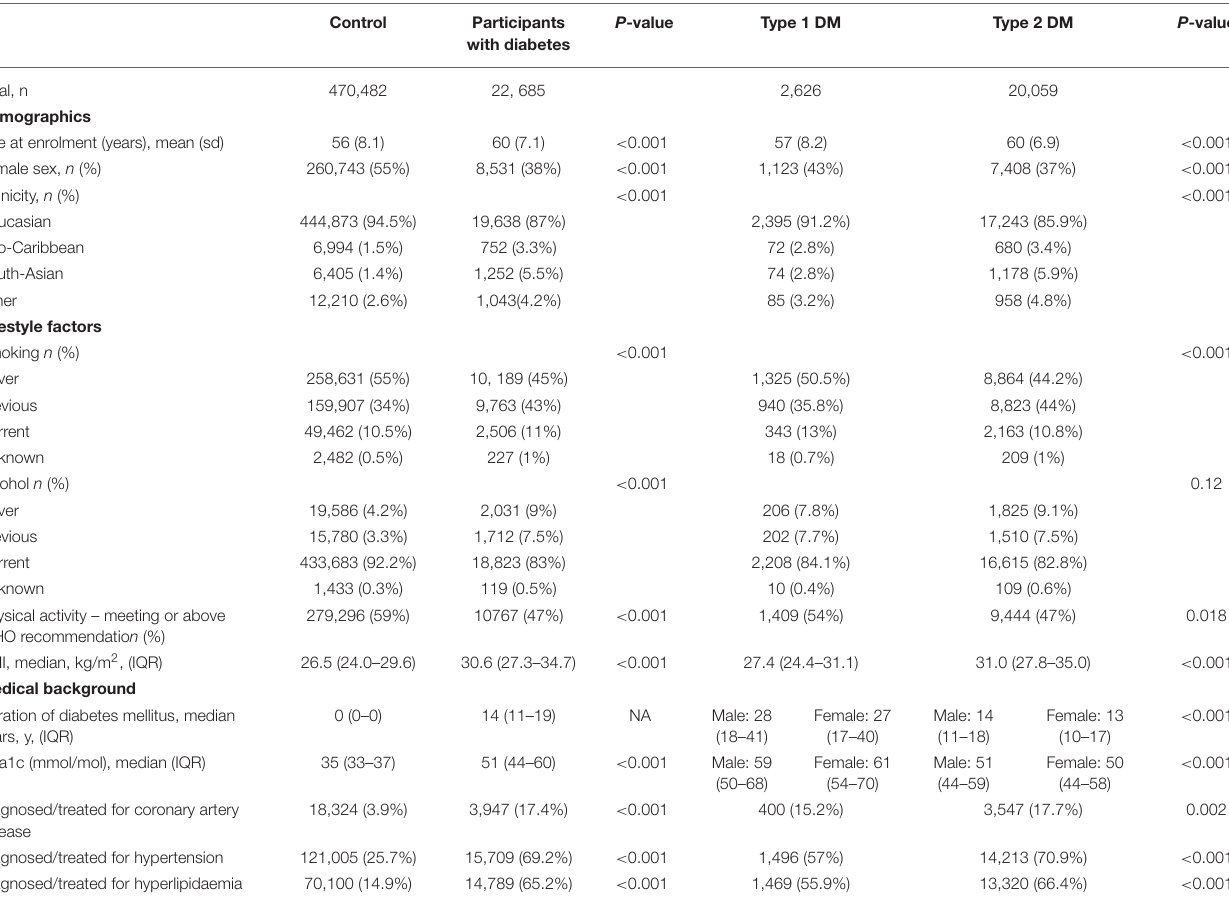
TABLE 1 | Participants’